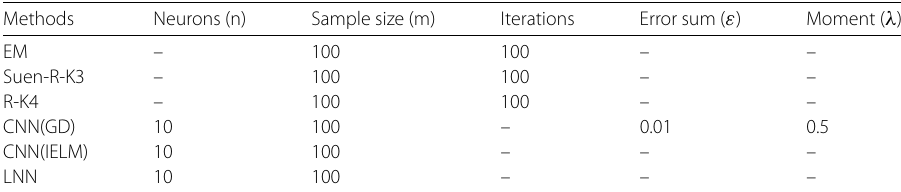
Table 6 Mean absolute deviation of different methods for second-order ODEs ODEs SM Example 5